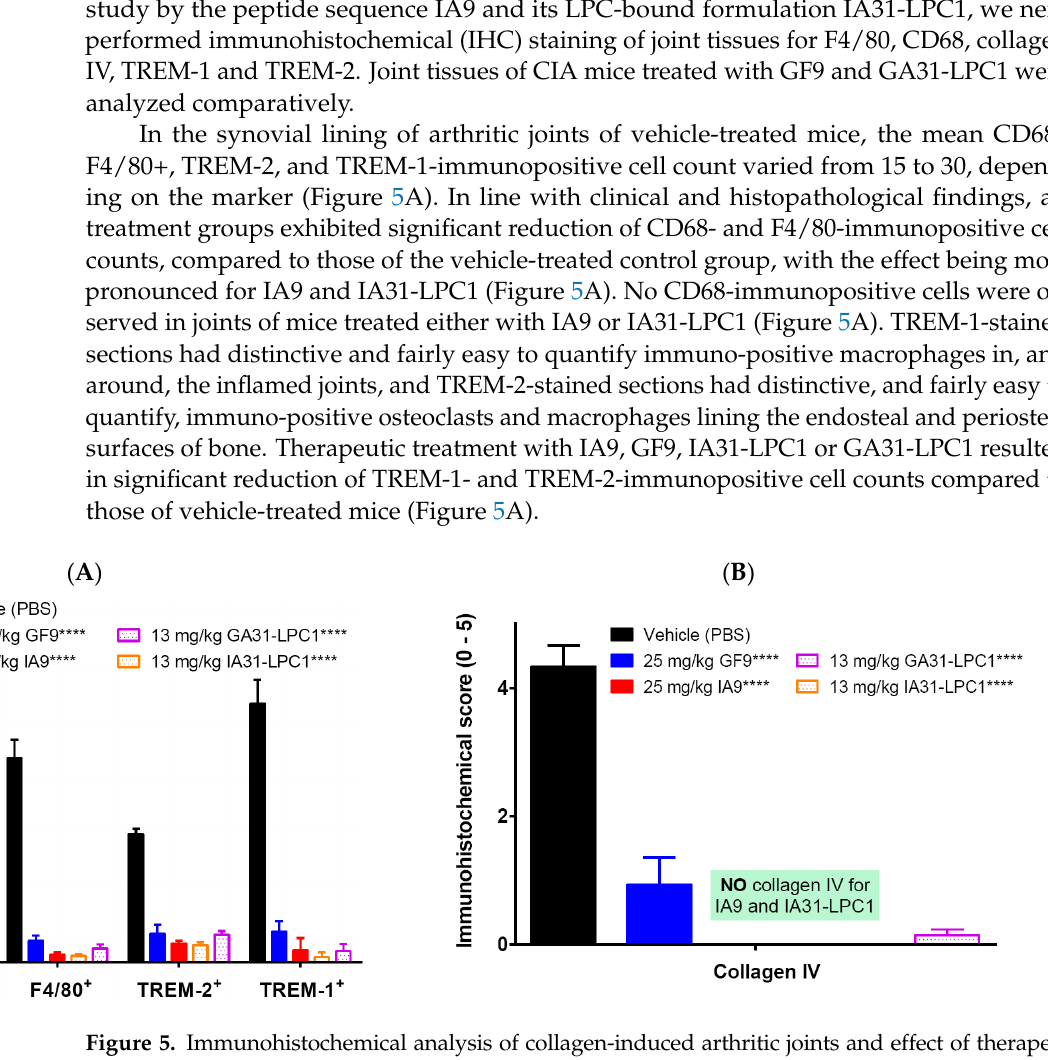
Figure 5. Immunohistochemical analysis of collagen-induced arthritic joints and effect of therapeu- tic treatment with free and LPC-bound IA9 and GF9 sequences on the number of CD68-, F4/80-, TREM-2- and TREM-1-positive cells ( A ) and collagen IV immunostaining score ( B ). Data are shown as mean ± SEM ( n = 8). ****, p < 0.0001 versus